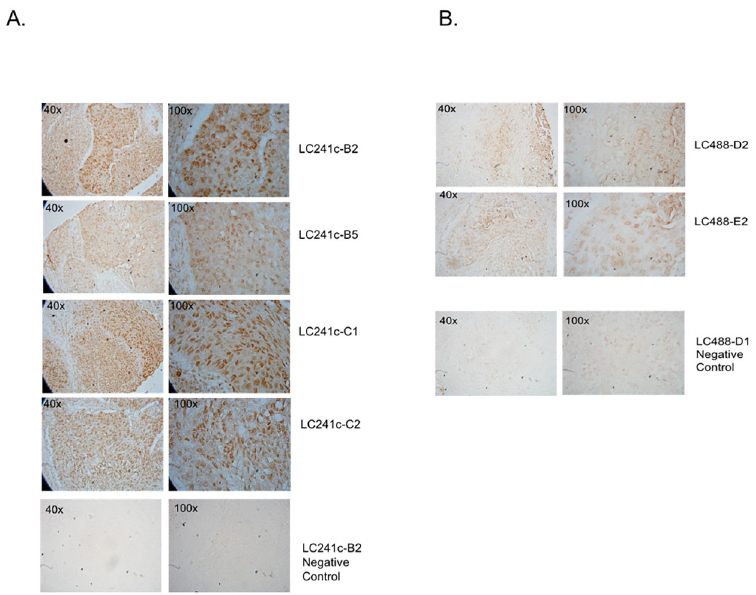
Fig 6. High grade tumors have strong staining for Rb S249 phosphorylation. IHC staining showing a strong nuclear staining for phospho-Rb S249 in four high grade SCC tissue cores (A). These four SCC cores all had a tumor grading of 3 and a Rb phospho-S249 staining score of 3. In contrast, grade 1 SCC cores had a Rb phospho-S249 staining score of 0 (B). Panels at the bottom of each figure are negative controls in which the primary antibody was omitted from the IHC